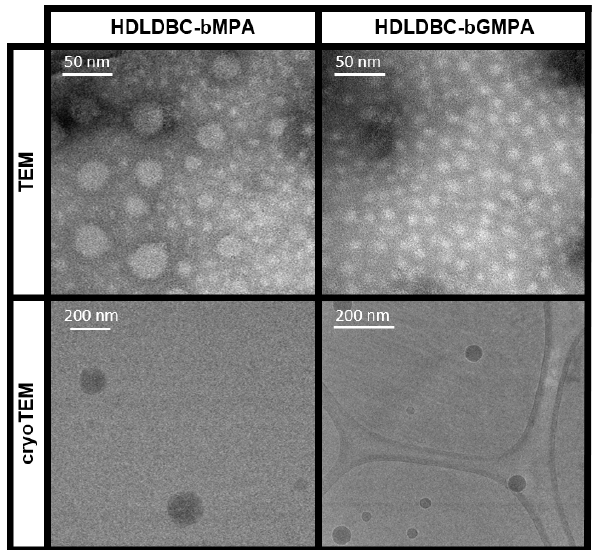
Figure 2. Characterization of the nanocarriers. TEM and cryoTEM images of HDLDBC-bMPA and HDLDBC-bGMPA. Table 1. TEM, cryoTEM and DLS size data in nm measured for HDLDBC-bMPA and